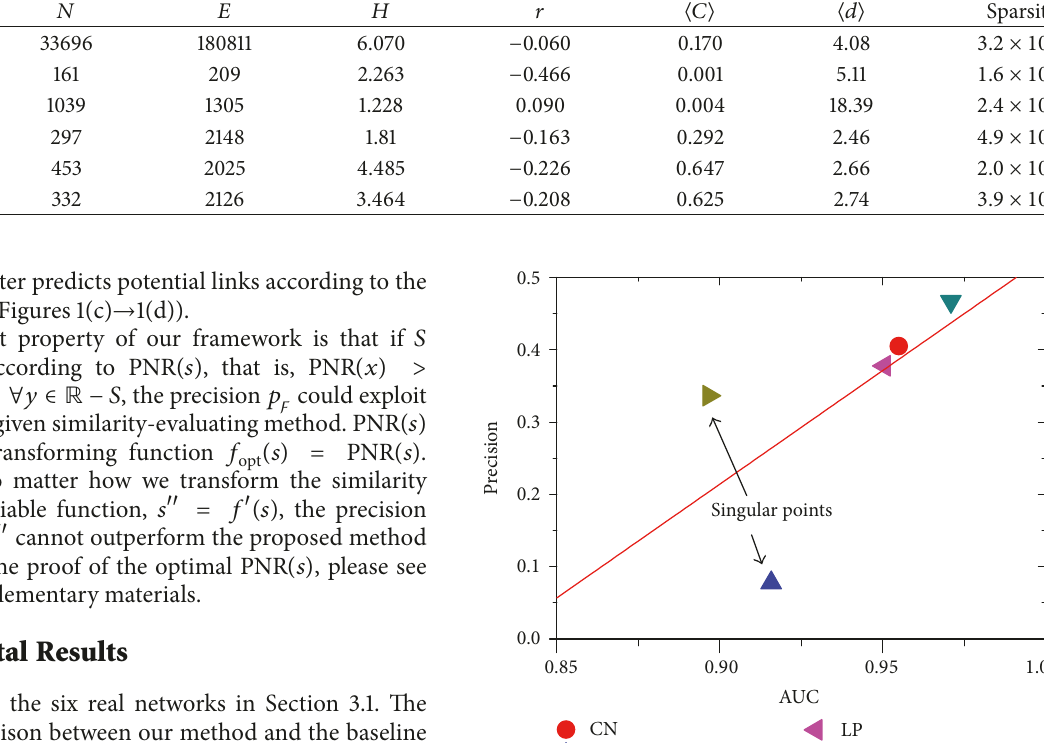
Table 1: Structural properties of the different real networks. Structural properties include network size ( 𝑁 ), link number ( 𝐸 ), degree heterogeneity (𝐻 = ⟨𝑘 2 ⟩/⟨𝑘⟩ 2 ) , degree assortativity ( 𝑟 ), average clustering coefficient (⟨𝐶⟩) , average shortest path length (⟨𝑑⟩) , and sparsity. Network